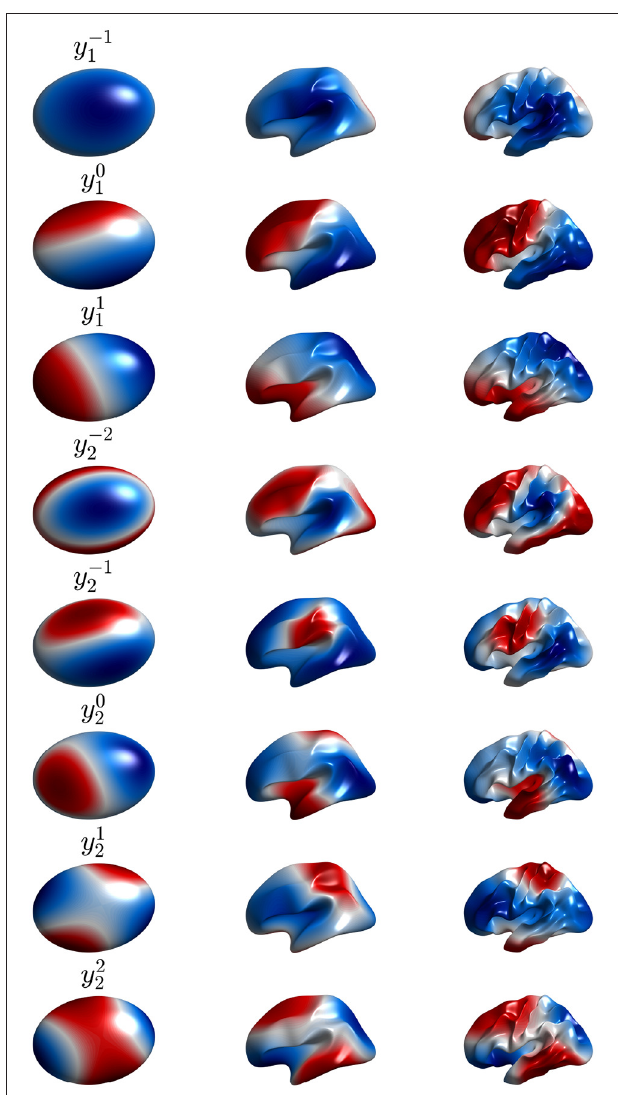
FIGURE 9 | Second to ninth real eigenmodes vs. cortical folding, with each row corresponding to one mode, as labeled. Moving from left to right corresponds to the cortex being gradually folded toward its final shape, starting from an ellipsoid. In each case the modes are calculated on the surface using the formulas of Gabay and Robinson (2017) with positive and negative regions distinguished by